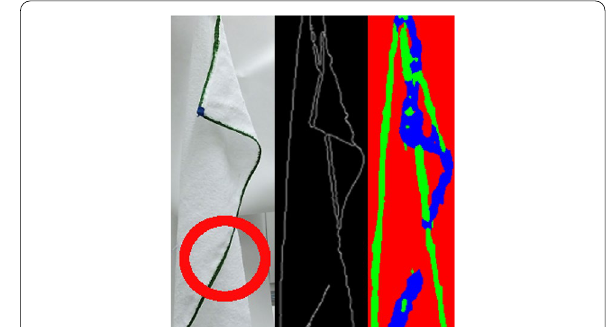
Table 3 Success ratios for different unseen cloths during training